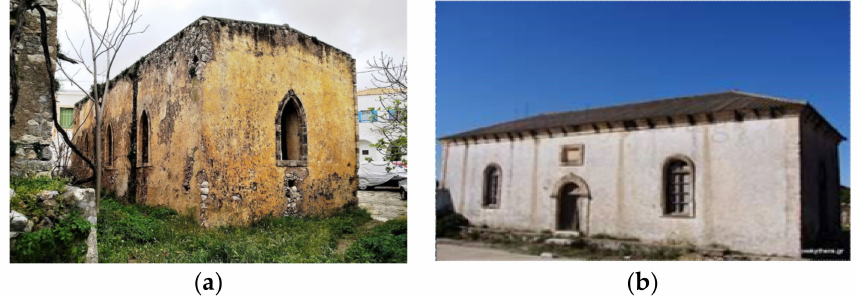
Figure 4. ( a ) The English School of Kato Chora, ( b ) The English School of Potamos in Kythera, Greece. Kythera also has a large number of settlements. Within the census of 1889, a total of 87 settlements appear on the island of Kythera [31]. Today Kythera has a total of 62